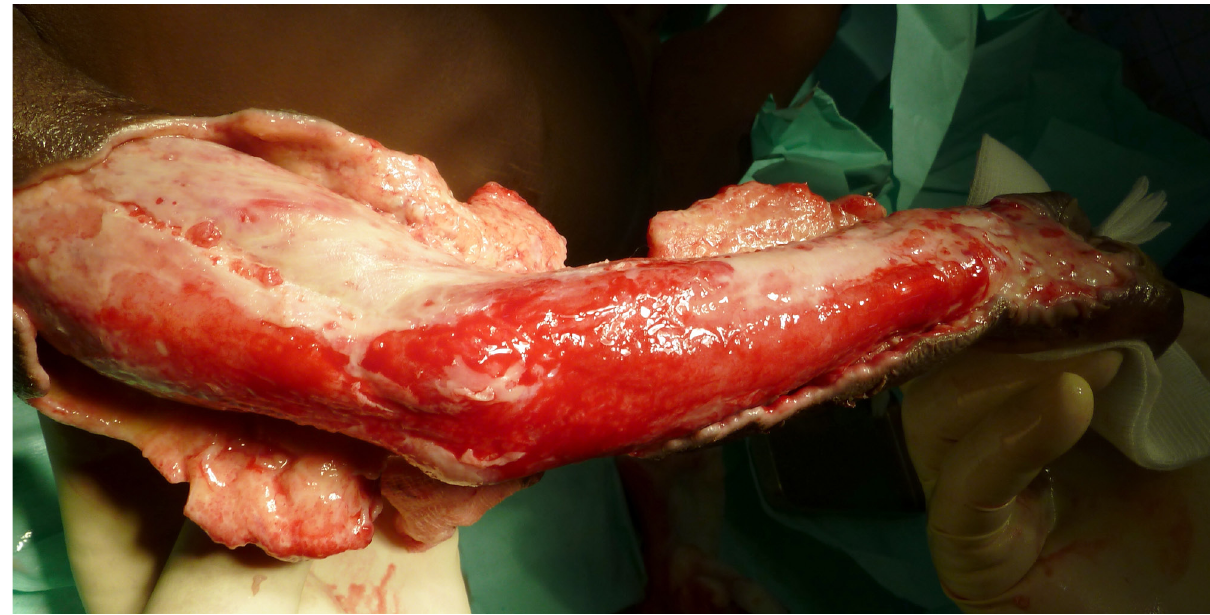
Figure 3. Wound cleaning.